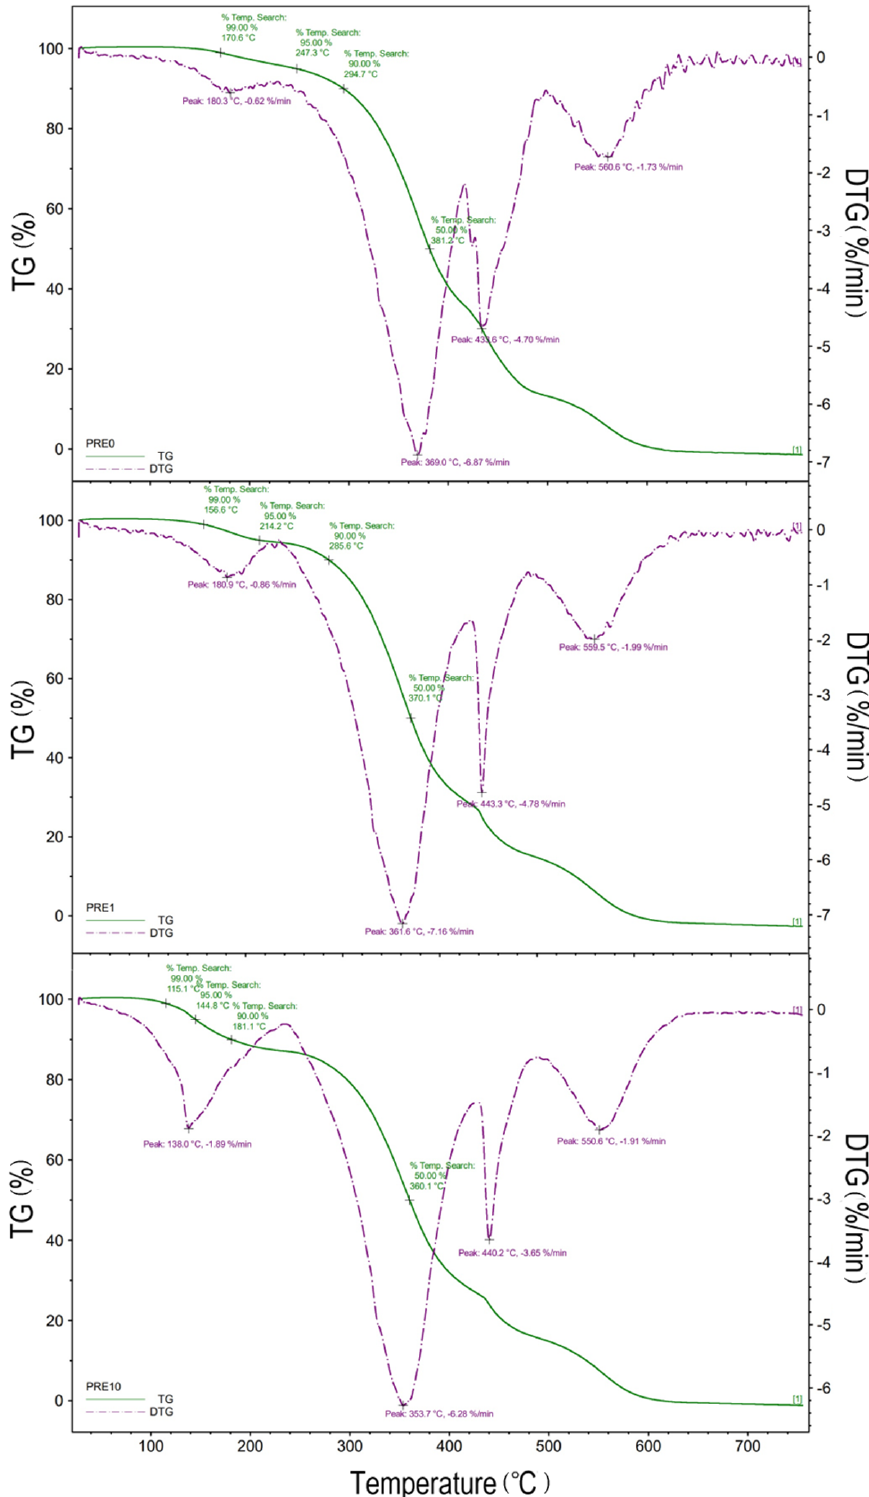
Figure 5. TGA and DTG data coatings based on urethane acrylate with different amounts of